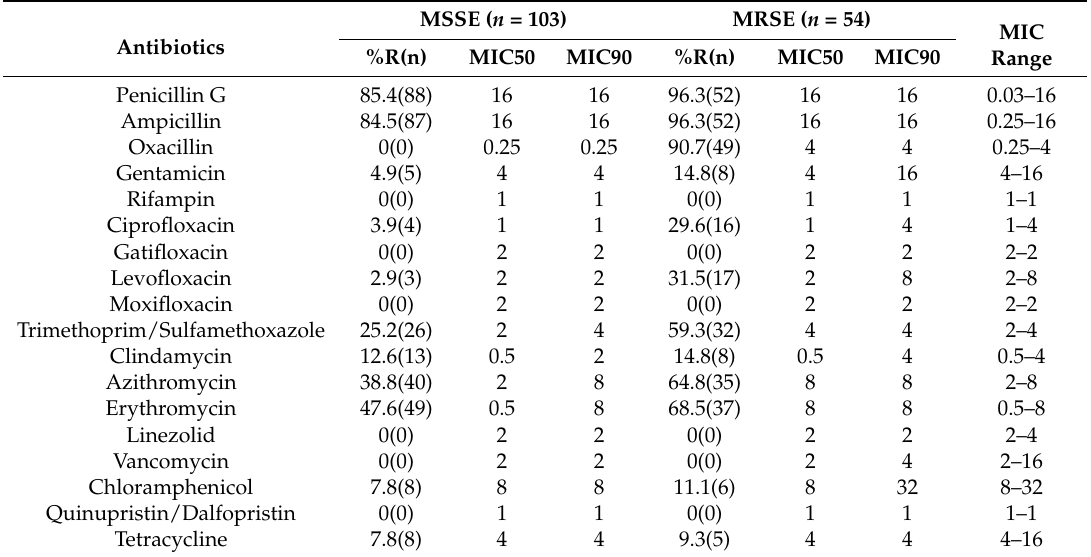
Table 1. Resistance profiles of 54 methicillin-resistant S. epidermidis (MRSE) isolates and 103 methicillin-susceptible S. epidermidis (MSSE)